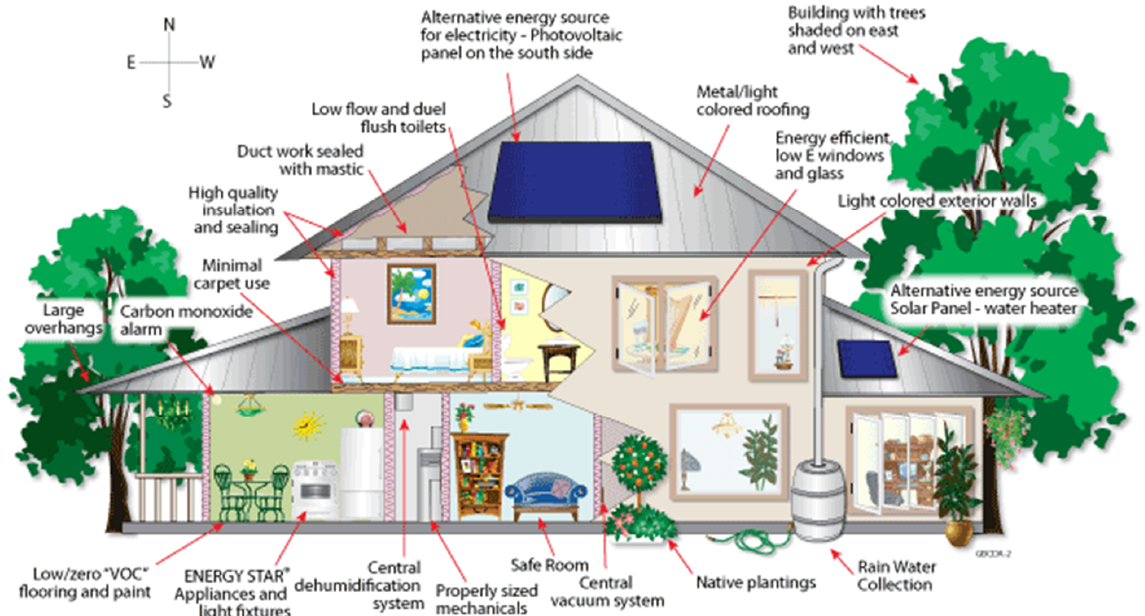
Fig. 1. Schematic of Green Building (Source: http://www.myfloridagreenbuilding.info/